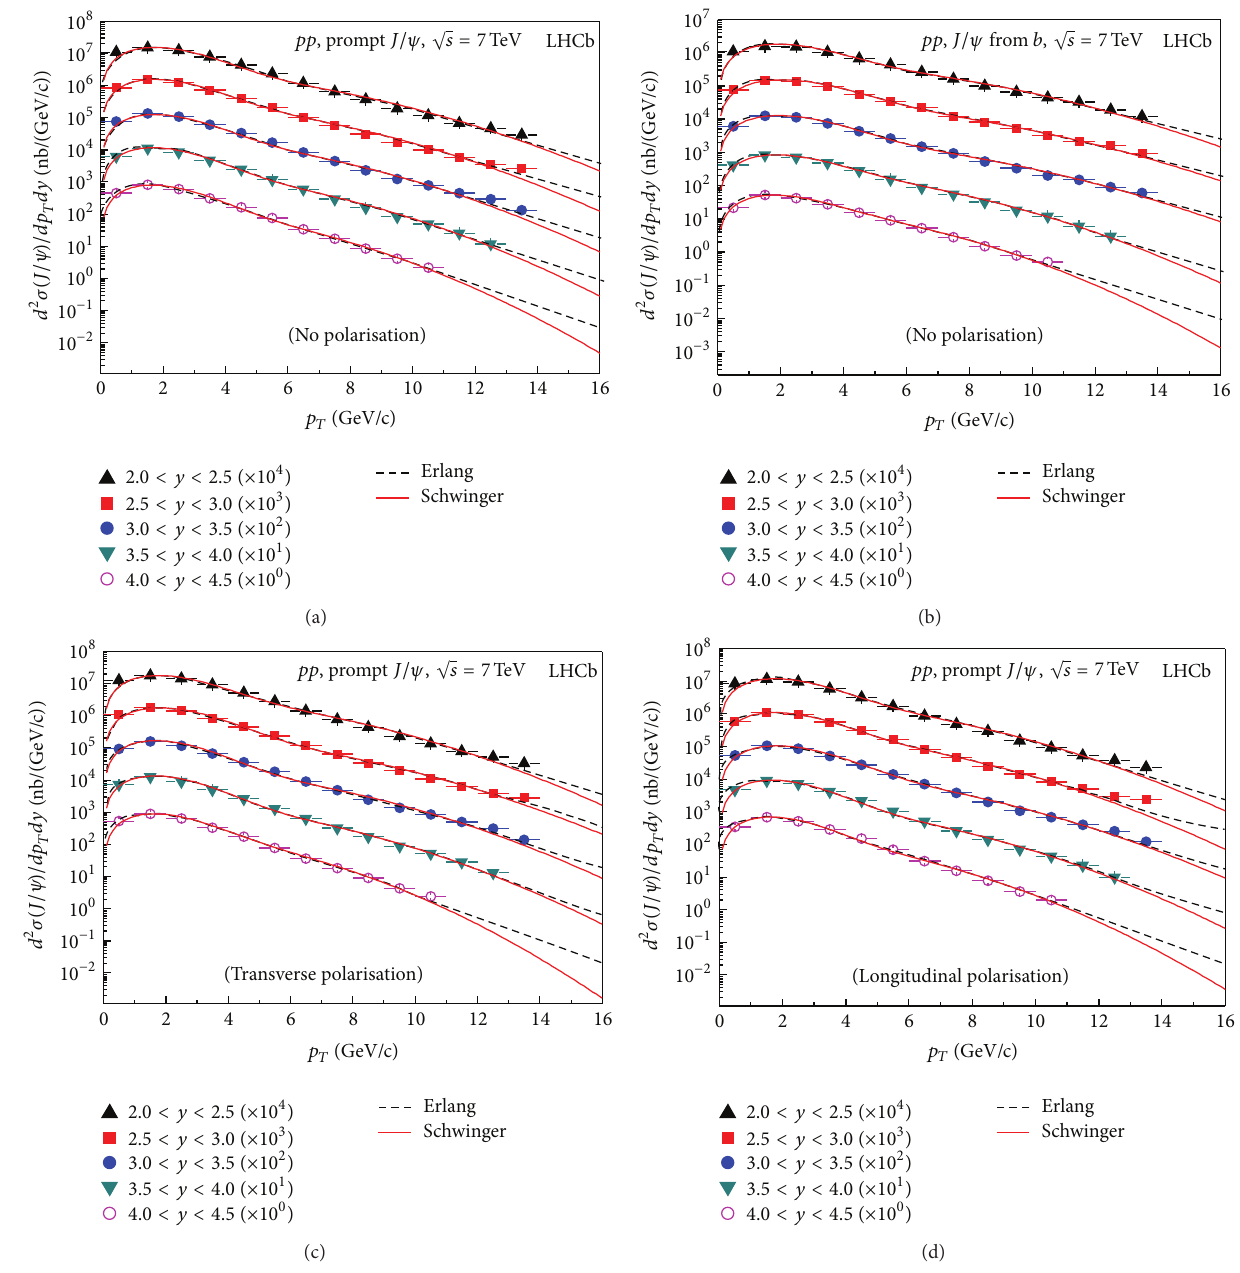
Figure 1: Transverse momentum spectra of (a) prompt 𝐽/𝜓 with no polarisation, (b) 𝐽/𝜓 from 𝑏 with no polarisation, (c) prompt 𝐽/𝜓 with full transverse polarisation, and (d) prompt 𝐽/𝜓 with full longitudinal polarisation in 𝑝𝑝 collision at √𝑠 = 7 TeV. The symbols represent the experimental data measured by the LHCb Collaboration [17] in different rapidity ranges and scaled by different amounts marked in the panels. The dashed and solid curves are our results calculated by using the two-component Erlang distribution and the two-component Schwinger mechanism,